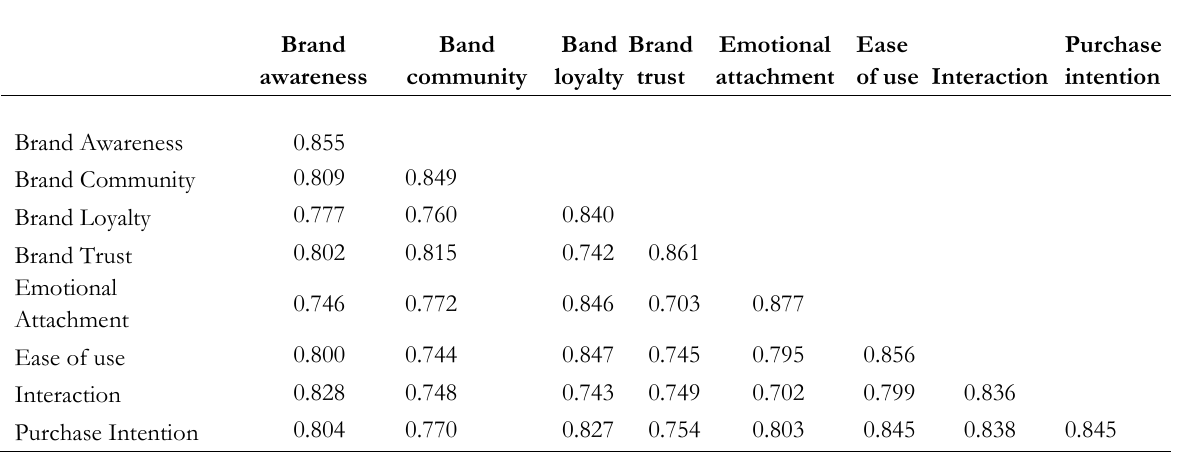
Table 3: Discriminant validity through Fornell-Larcker Criterion